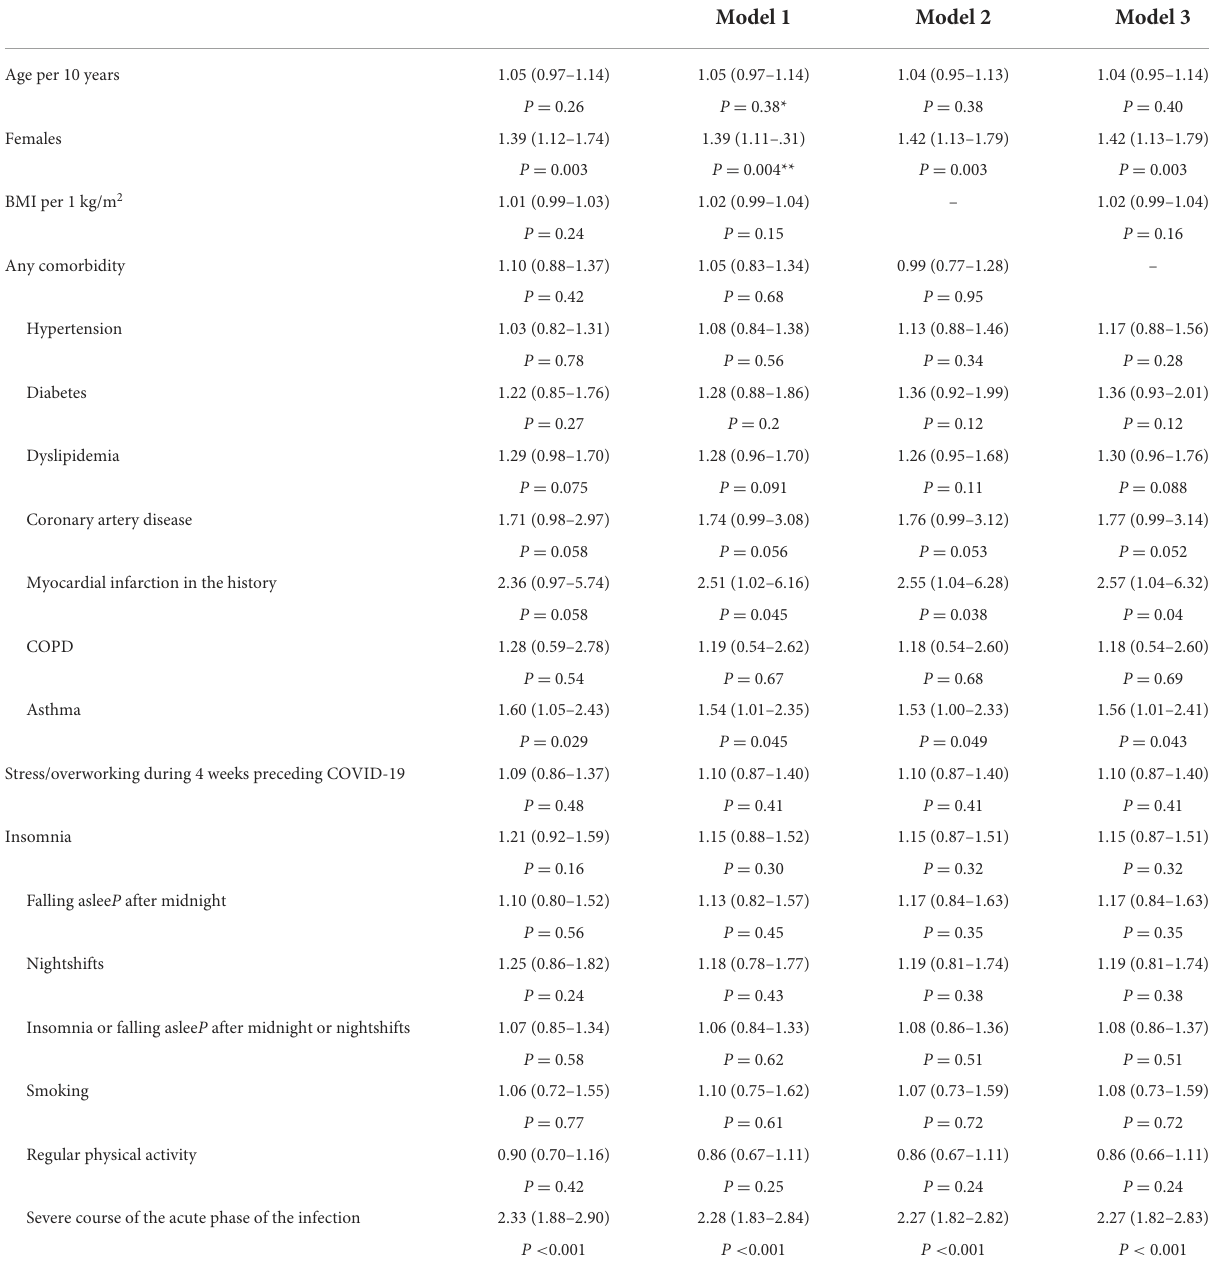
TABLE 4 Multivariate analysis of predictors of Long-COVID signs and